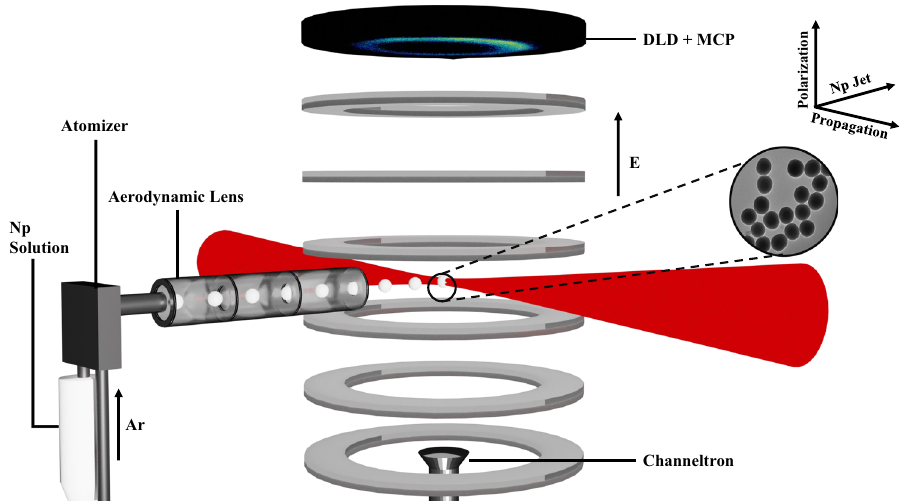
Fig. 5 Experimental setup. Illustration of the experimental setup showing the nanoparticle solution (Np Solution) that is aerosolized by an atomizer with the help of Ar as carrier gas. The aerosol is then collimated using the aerodynamic lens producing a jet that is admitted to the ultrahigh vacuum chamber. The nanoparticles interact with the laser fi eld in the center of a constant- fi eld (E) spectrometer. The ions generated from the interaction are accelerated towards a microchannel plate (MCP) and delay-line detector (DLD). As for the electrons, they are accelerated towards a channeltron and are used to discriminate between nanoparticles and background ions. The inset shows a scanning electron microscope (SEM) image of the silica nanoparticles (NanoComposix) used in the